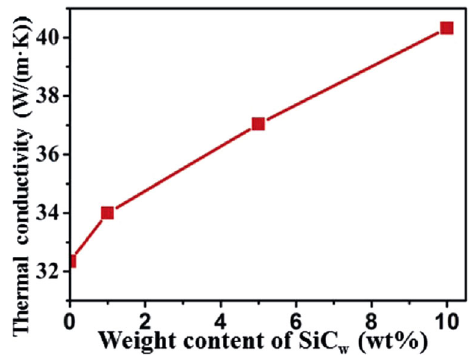
Fig. 11 k of SiC w /Ti 3 SiC 2 as a function of SiC w